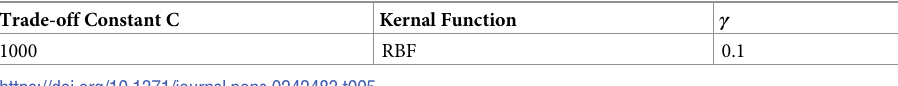
Table 5. Parameters for SVR model with filtered features.